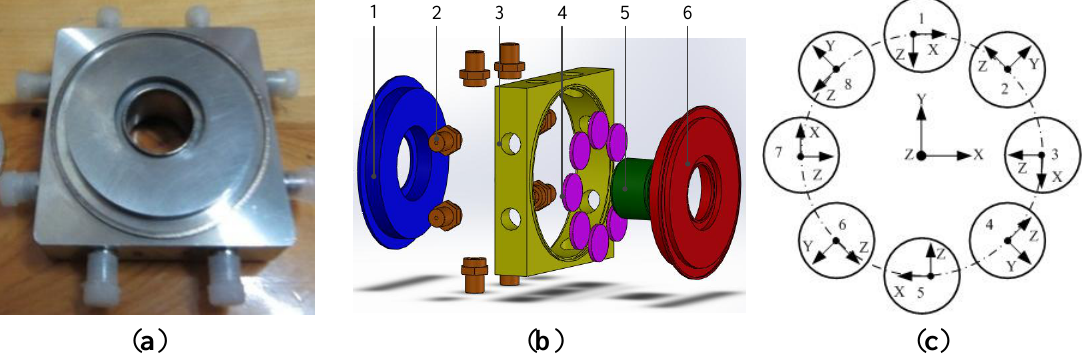
Figure 1. Schematic diagram of piezoelectric 6-axis force sensor. ( a ) Photo of a piezoelectric six-axis force sensor. ( b ) Exploded view of a six-axis force sensor. ( c ) Spatial layout structure schematic of quartz chip